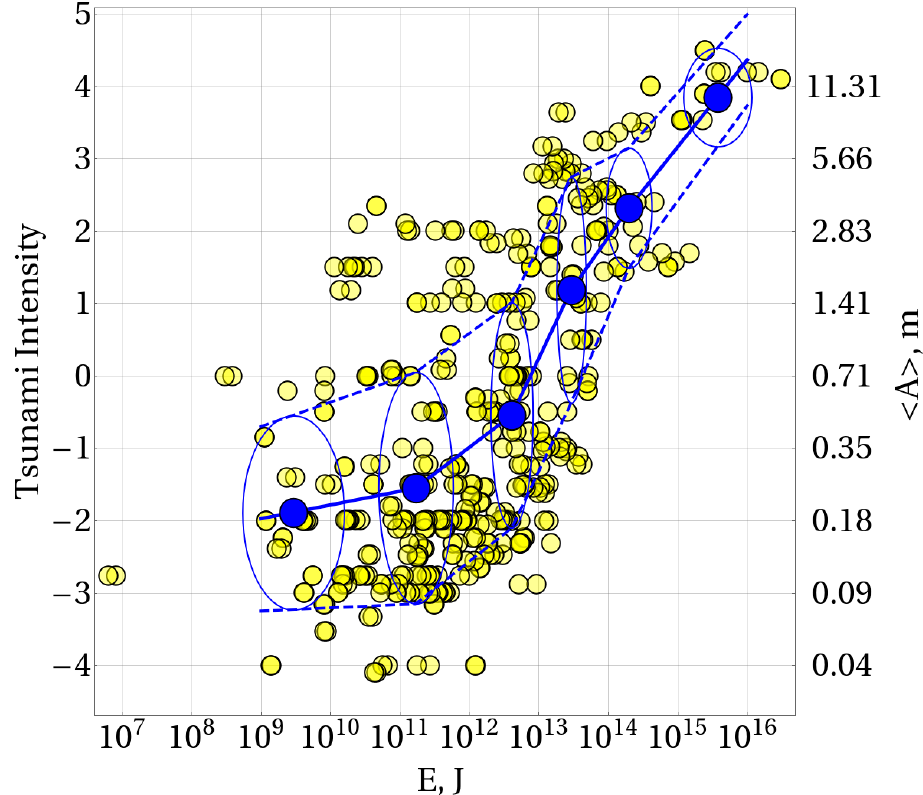
Figure 4. Dependence of the tsunami intensity on the Soloviev–Imamura scale on the energy of the initial elevation according to data on 218 historical events (yellow circles). The blue dots were obtained as a result of averaging the original data by group. Ellipses represent the 68% confidence interval (standard deviation). The solid line is a linear interpolation of the intensity’s dependence on energy, and the dotted lines are a linear interpolation of the 68% confidence interval.